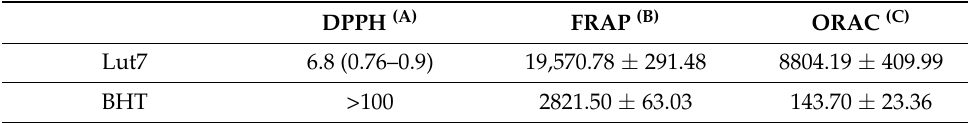
Table 1. Antioxidant activity of Lut7 and